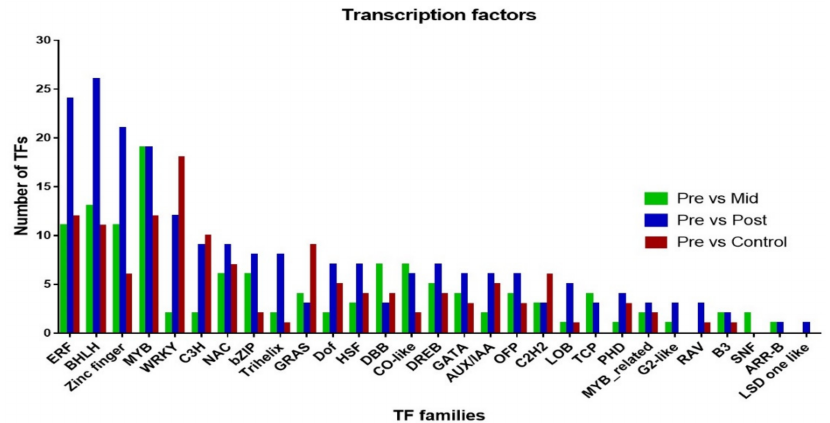
Figure 7. Distribution of transcription factors DEG from three analyses: plants before blanching versus mid–blanching; plants before blanching versus post–blanching; and plants before blanching versus control conditions.